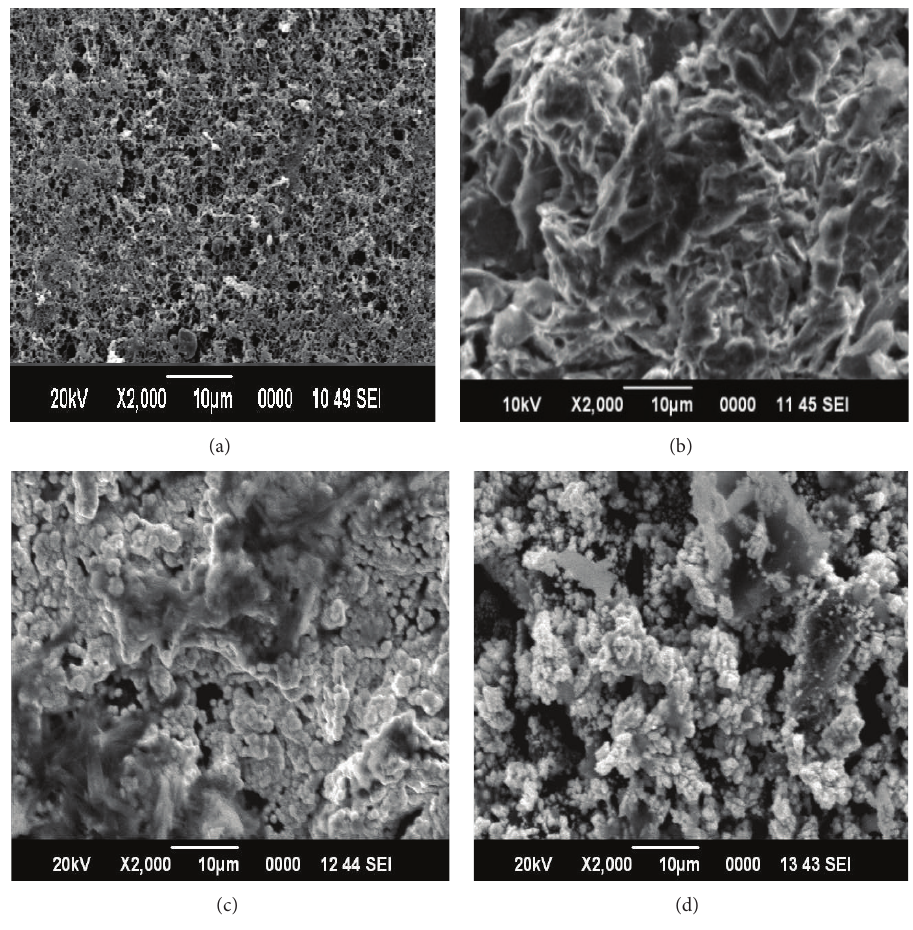
Figure 2: SEM images of (a) C-PANI, (b) C-PANI-Ni, (c) C-PANI-Pd, and (d) C-PANI-Pd-Ni electrodes. Table 1: Comparison of different electrochemical parameters for methanol oxidation on different electrodes. Electrochemical parameters